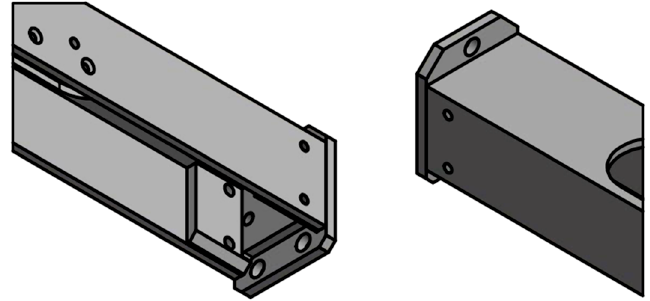
Figure 4. Lid proposed redesign using bolted assembly.